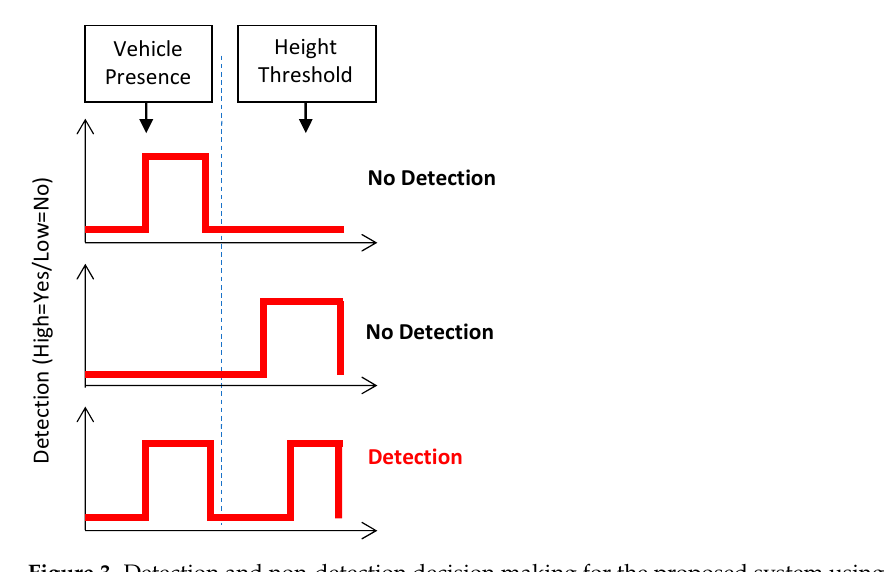
Figure 3. Detection and non-detection decision making for the proposed system using vertical and horizontal sensor data.